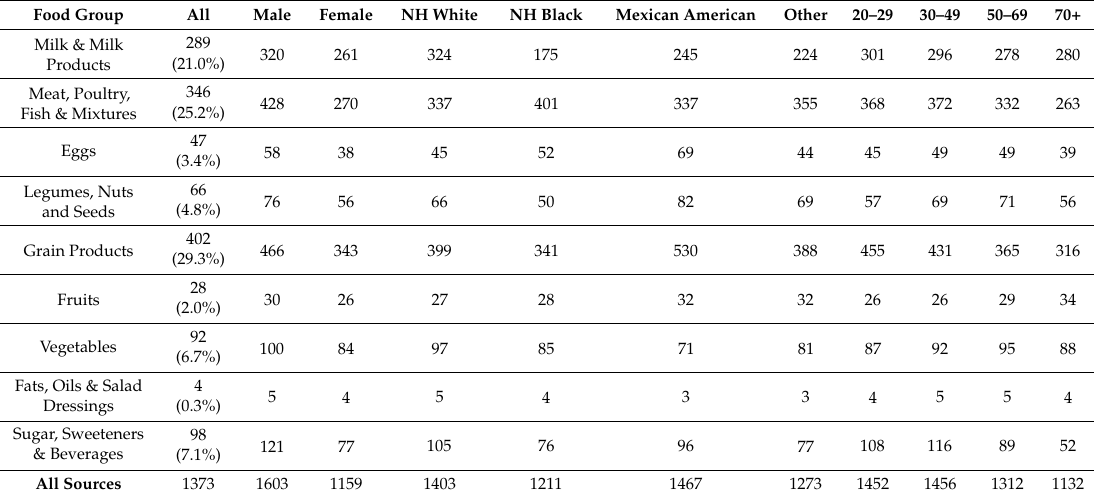
Table 3. Estimated total dietary phosphorus (mg/day) by USDA food group in NHANES WWEIA 2001–2014 in adults 20 years of age or